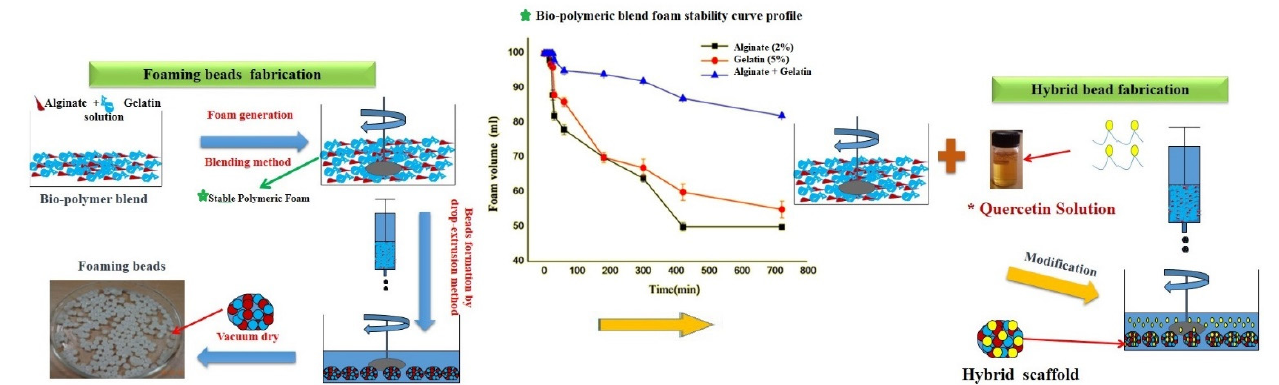
Figure 1. Schematic presentation of biogenic 3D polymeric foaming bead fabrication and quercetin- loaded hybrid beads with polymeric foaming stability curve showing significant foaming stability with time. Here, Green * labelling represents the foam stability curve of the polymeric blend indicates the stable foam generation of alginate-gelatin polymeric blend to bead fabrication and red * for quercetine solution for the modified alginate-gelatin bead formation. Table 1. Chemical composition of drug-loaded scaffolds with different concentrations. Chemical Components